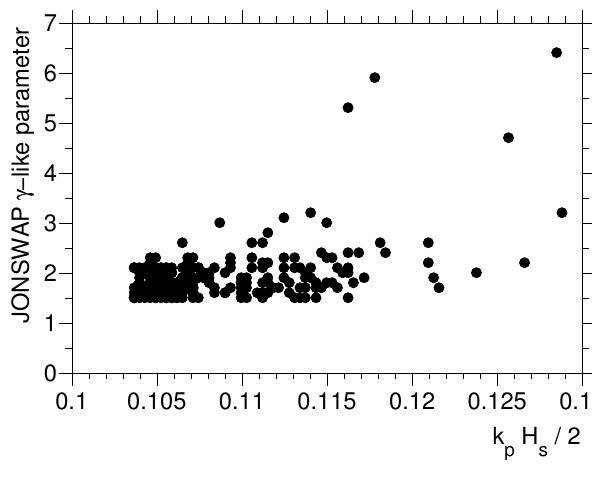
Fig. 1. Scatter diagram of significant wave height ( H s ) and spec- tral peak period ( T p ) for total seas from Oceanweather Inc. hindcast data; lines of constant spectral steepness (k p H s / 2 = 0.10 and 0.13) are included.